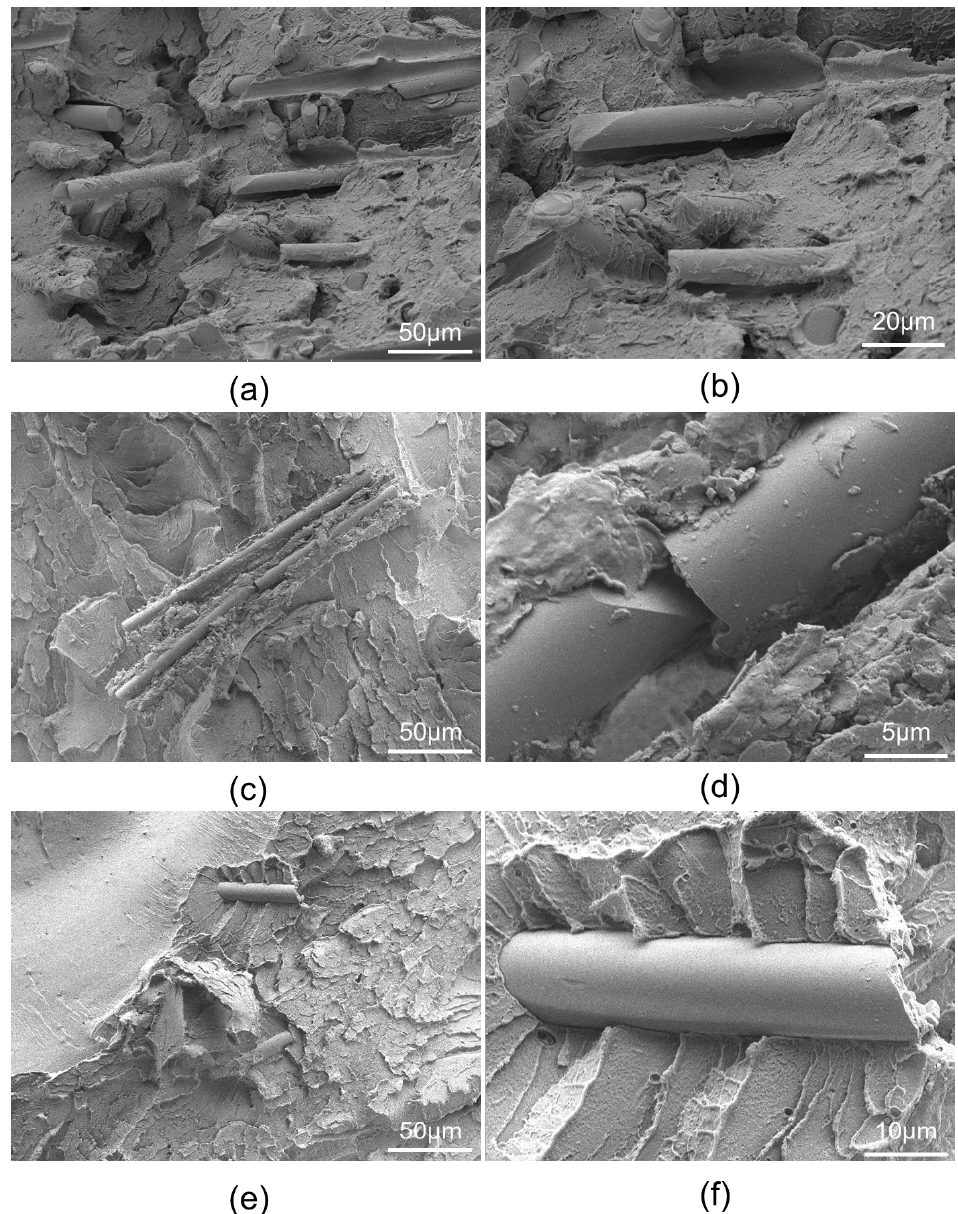
Figure 4. High-magnification images of the fracture surfaces: ( a , b ) GF/PEI-0 and ( c , d ) GF/PEI-85 and ( e , f ) GF/PEI-145 .